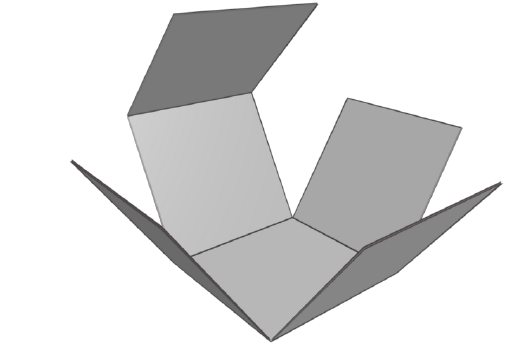
(a) Unfolded net of the cube, where the arrows (b) Just before the cube is finished folding. All curvature is absorbed in the corners of the cube. Figure 1: How the net of a cube folds into a